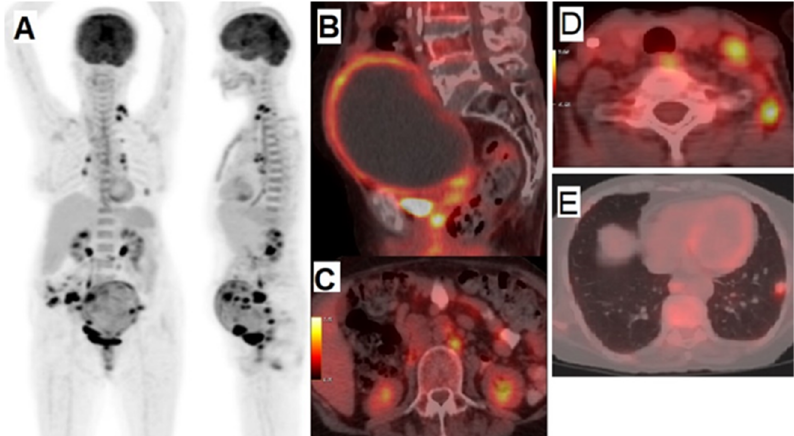
Figure 2. A 66-year-old female presented with a pelvic mass and vaginal bleeding. Cervical squamous cell carcinoma (SCC) was confirmed via biopsy and referred for staging. ( A ) Disease distribution visualized with [ 18 F]FDG PET/CT imaging. ( B ) Sagittal pelvis image showing primary tumor leading to hydrometra and regional lymphadenopathies. ( C ) Retroperitoneal and ( D ) Supraclavicular lymph node metastases, in addition to lung metastases ( E ). (Pictures with courtesy from Department